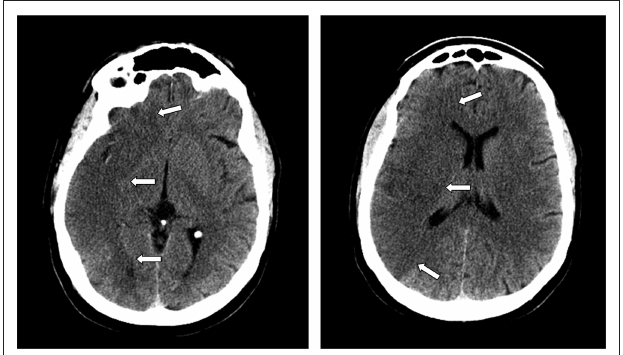
FIgure 1 | CT scan of the head without contrast showing multilobar hypodensity in the right hemisphere (arrows).